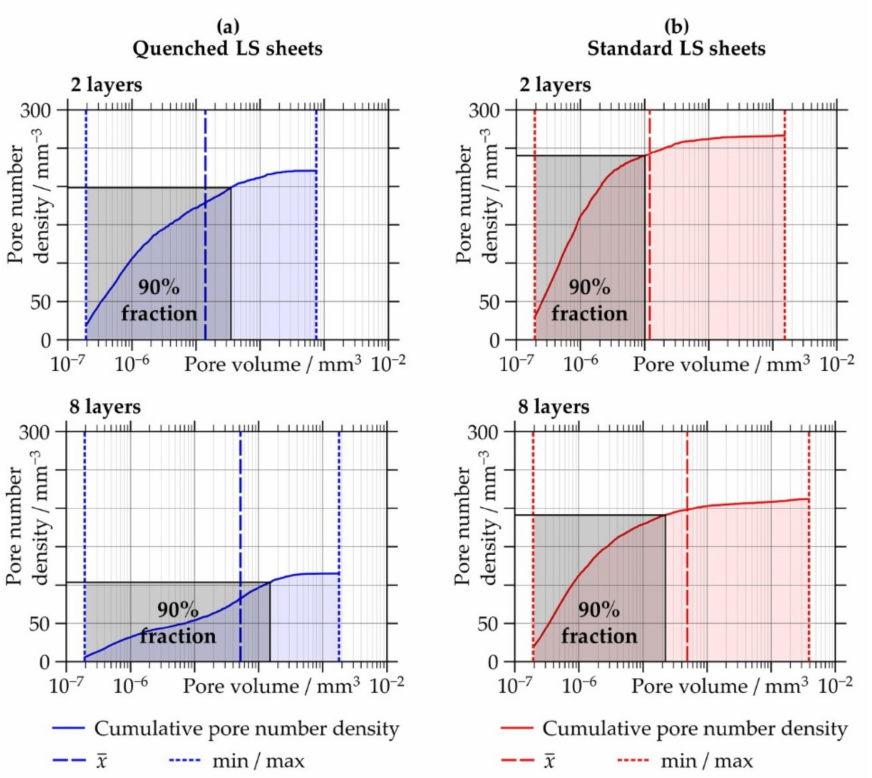
Figure 5. Cumulative pore number density distribution of different pore volumes of ( a ) quenched and ( b ) standard laser-sintered (LS) polyamide 12 sheets generated with two and eight layers. The black rectangles indicate the 90% fraction of the total number of detected